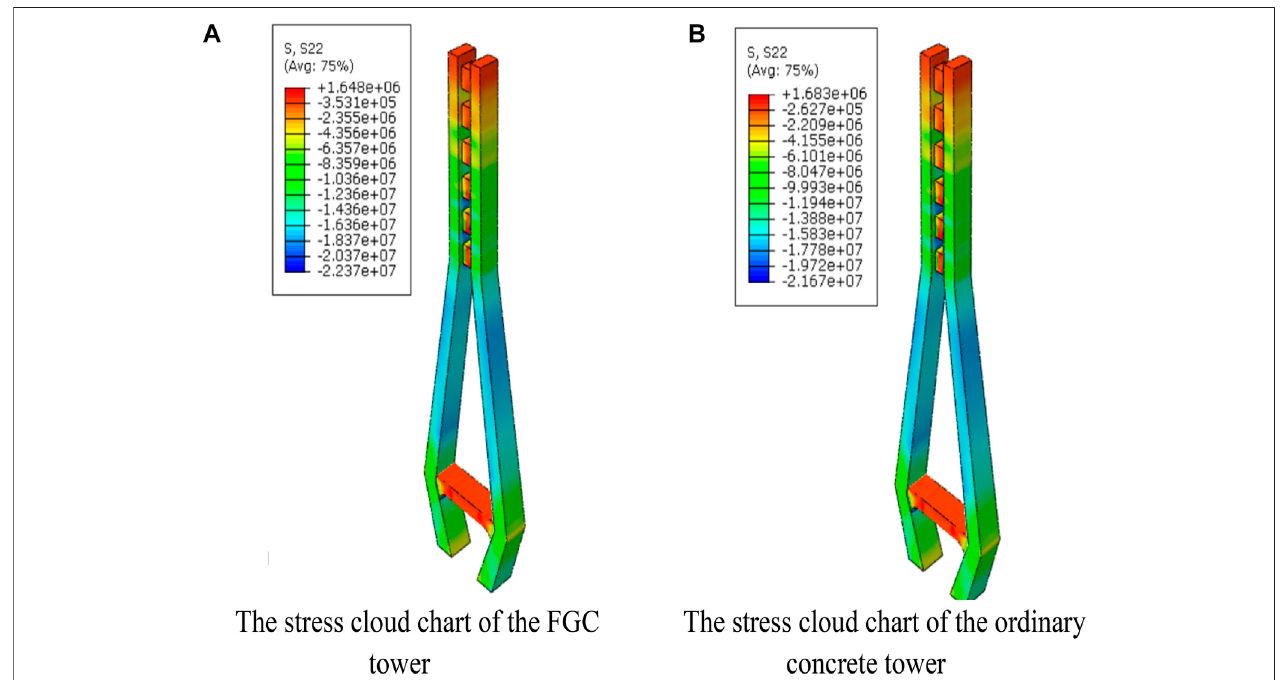
FIGURE5| Theaxialstresscloudchartoftheconcretetowerunder2.5times deadload. (A) ThestresscloudchartoftheFGCtower. (B) Thestresscloudchartof the ordinary concrete tower.